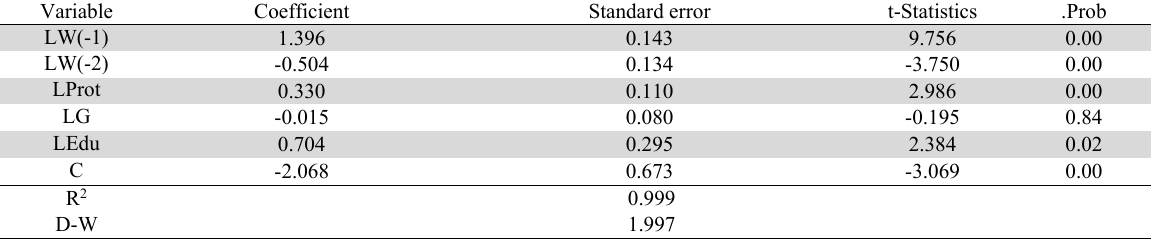
Investigating the short-run relationship between total productivity and wages without time trend Variable Coefficient Standard error